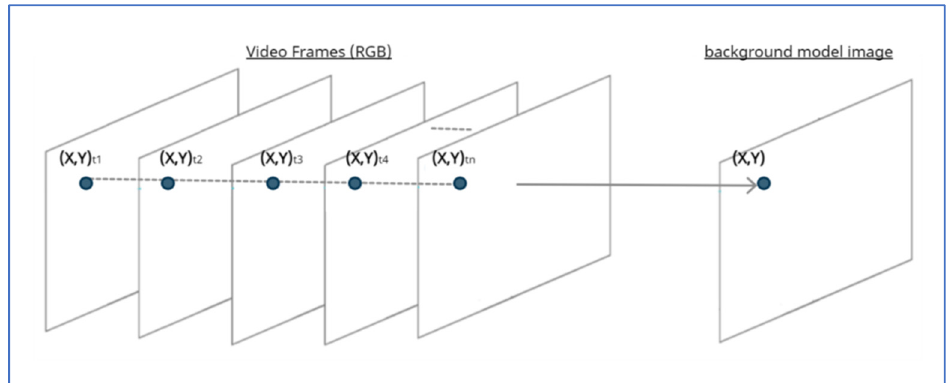
Figure 1. Simulating background modeling starting from a set of frames to induce the static back- ground.